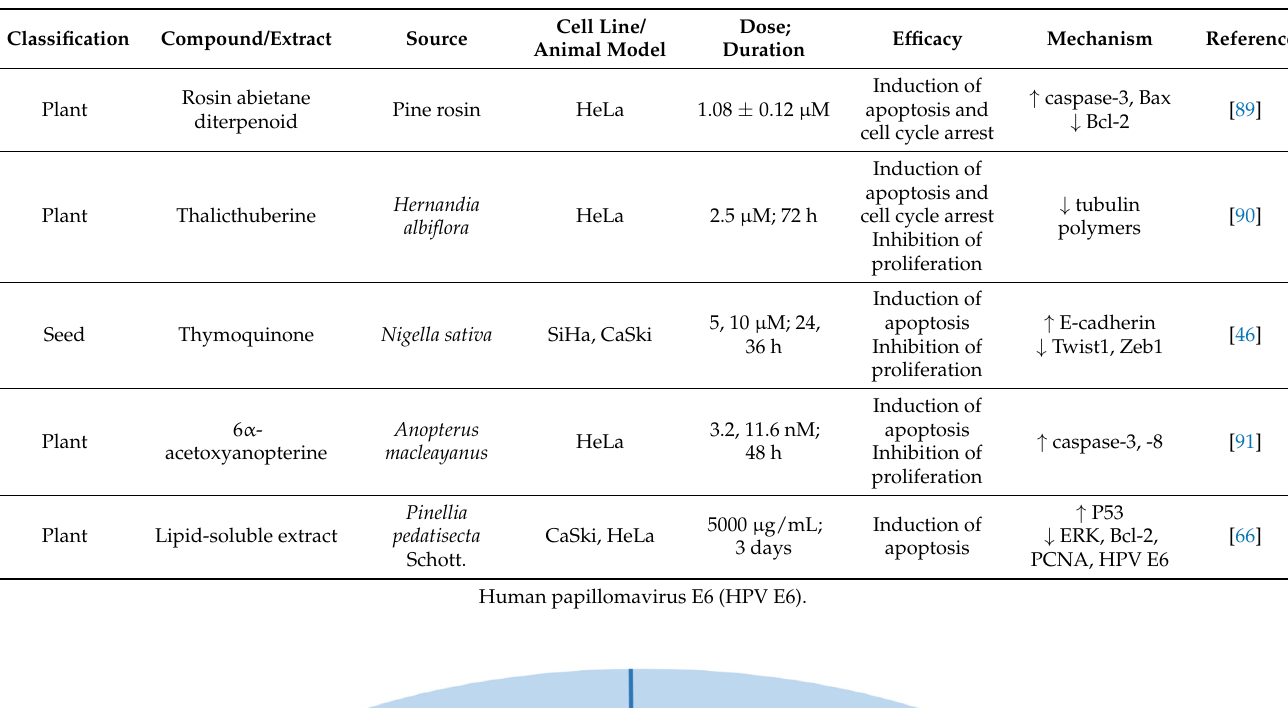
Table 5. Drug resistance sensitizing natural products.